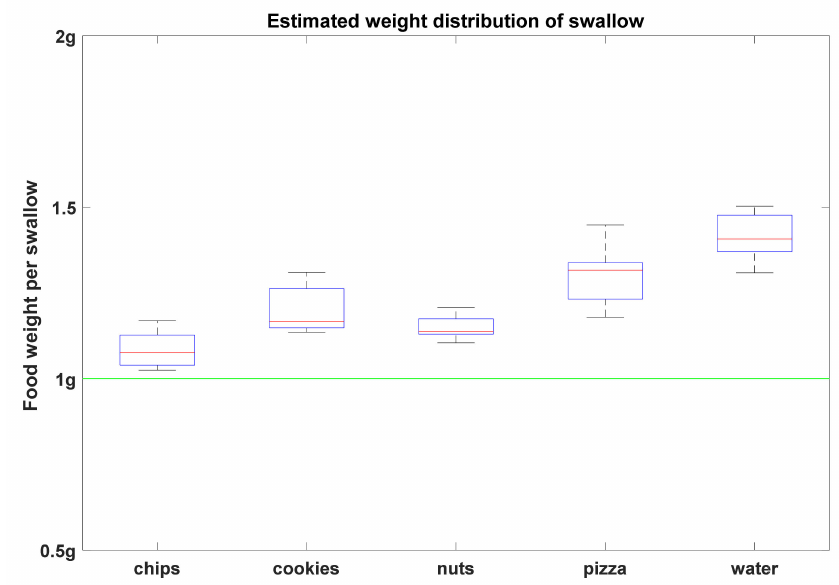
Figure 9. This figure describes the deviation of the estimated food weight from the actual weight of the consumed